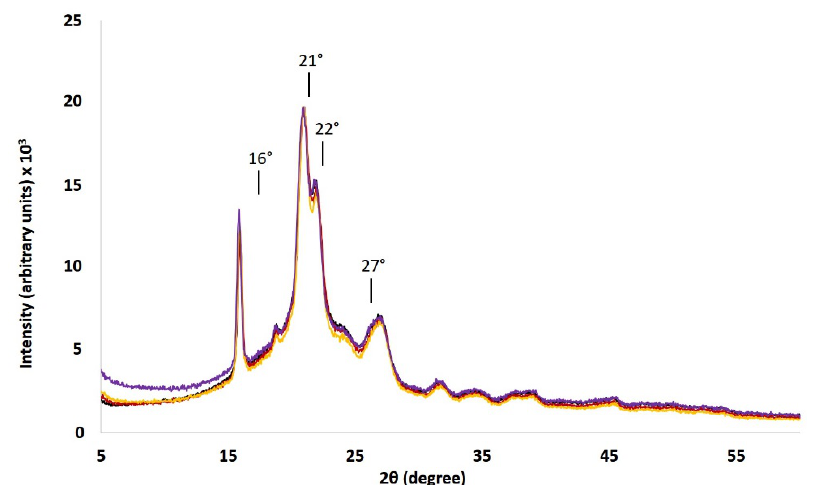
Figure 8. XRD patterns of the PTMC D - NH - Φ (black) and PTMC D - NH with DP n at 100 (red), 200 (yel- low) and 500 (purple).